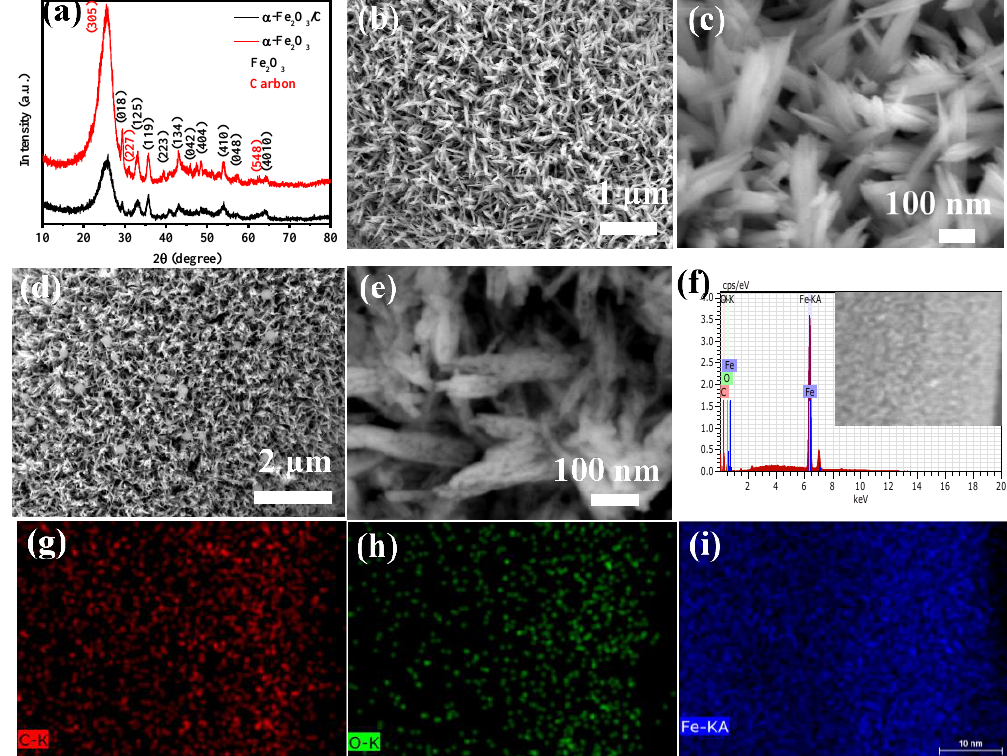
Figure 1. ( a ) XRD patterns of α-Fe 2 O 3 and α-Fe 2 O 3 @C nanowire arrays ( b , c ) SEM image of α-Fe 2 O 3 nanowire arrays ( d , e ) SEM images of α -Fe 2 O 3 @C nanowire arrays ( f – i ) EDS mapping of α -Fe 2 O 3 nanowire arrays ( d , e ) SEM images ofα-Fe 2 O 3 @C nanowire arrays ( f – i ) EDS mapping of nanowire arrays. α-Fe 2 O 3 nanowire arrays.